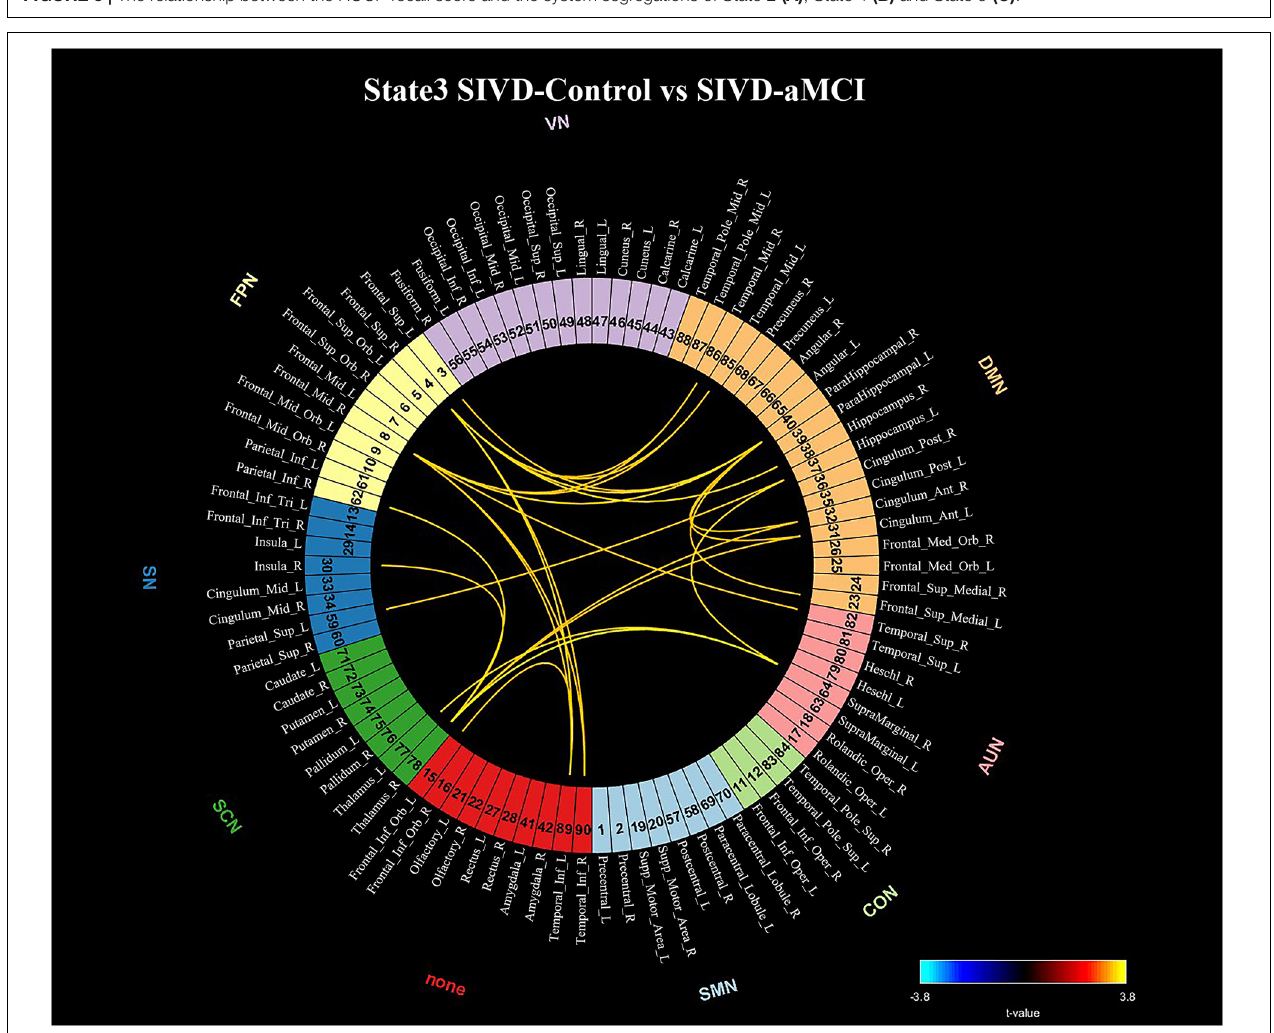
FIGURE 6 | Significant connectivity differences in State 3 between the SIVD-Control group and SIVD-aMCI group for the NBS method. The numbers associated with the listed brain region are the indices in the AAL